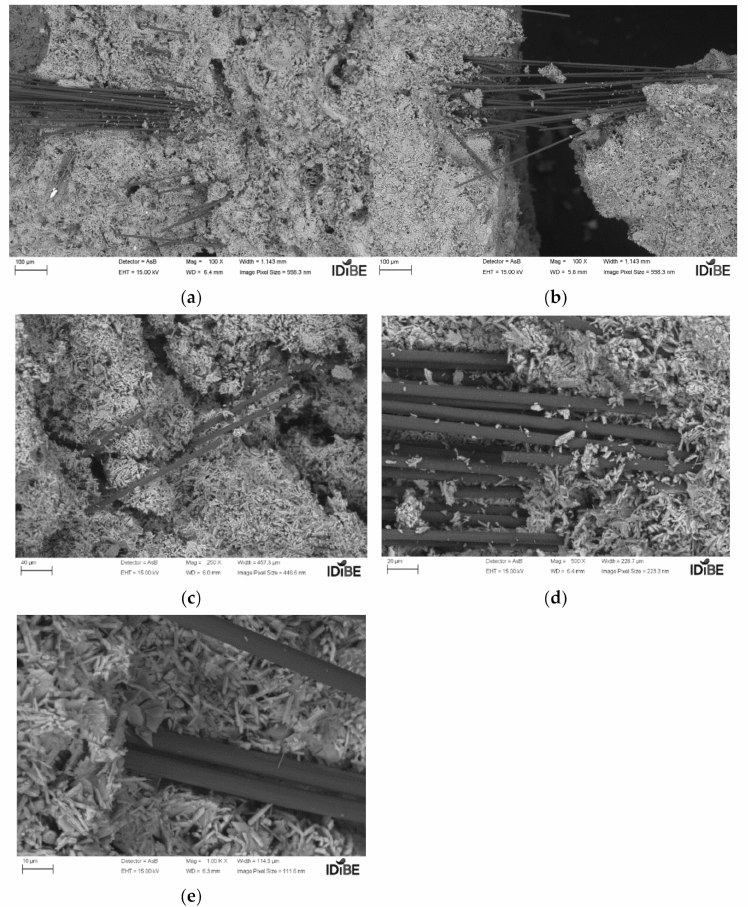
Figure 10. Carbon-calcium sulfate compound microscopy: ( a ) 100 µ m; ( b ) 100 µ m; ( c ) 40 µ m; ( d ) 30 µ m; ( e ) 10 µ m (source: the